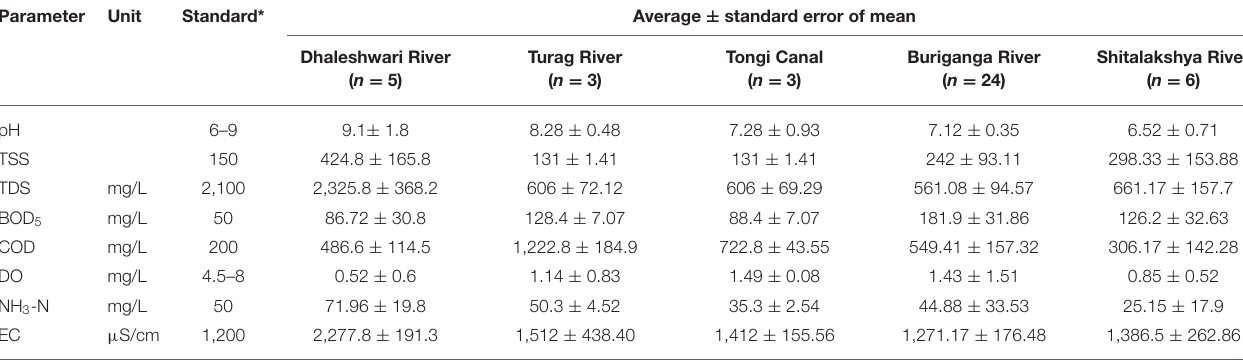
TABLE 2 | Results of water quality parameters of the selected outfalls from peripheral rivers of Dhaka City. Parameter Unit